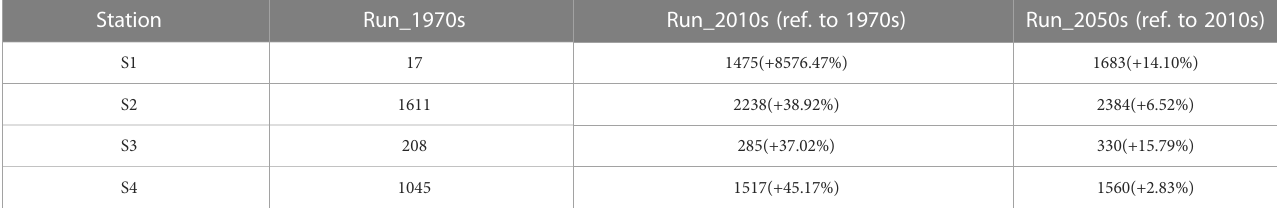
TABLE 2 Index of stability of strati fi cation at the four sites in the wet season.